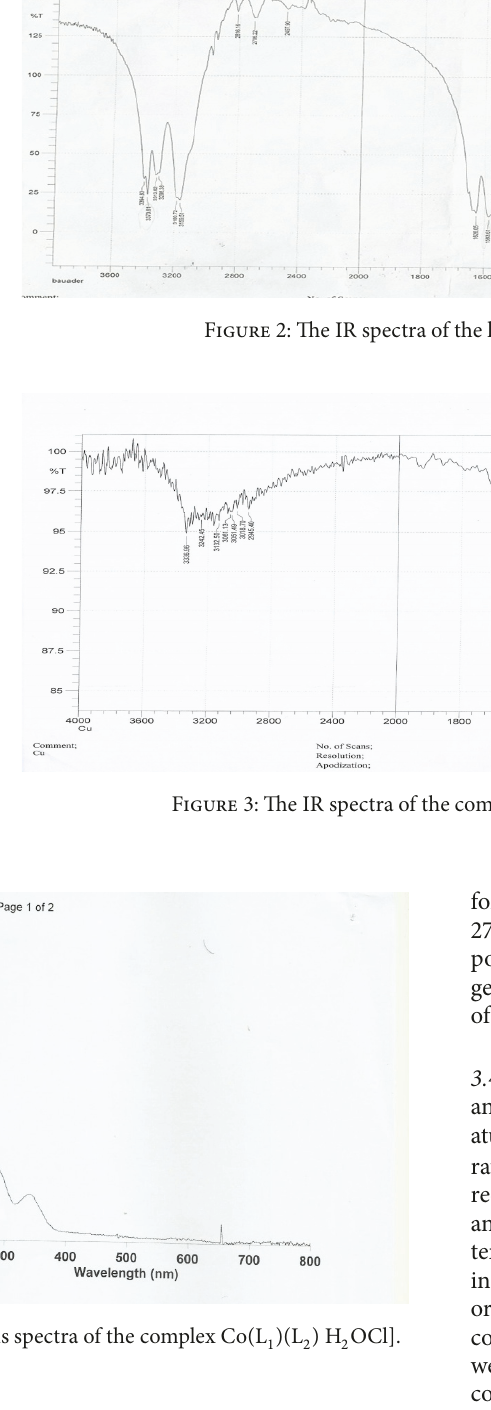
290 and 350 nm are assigned to n 󳨀→ 𝜋∗ transitions of (-C=N-, -C=C, C=O) groups and intraligand charge transfer [15]. Transition metal complexes showed the following 𝑑 󳨀→ 𝑑 transition. Two bands observed for Co +2 complex go to the 4 4 4 4 T 1 g 󳨀→ T 2 g(F) and T 1 g(F) 󳨀→ T 1 g(P), respec- transitions 5 2 eg ) tively, suggesting high spin octahedral geometry (t 2 g +2 complex, only two broad bands were [16]. For Cu